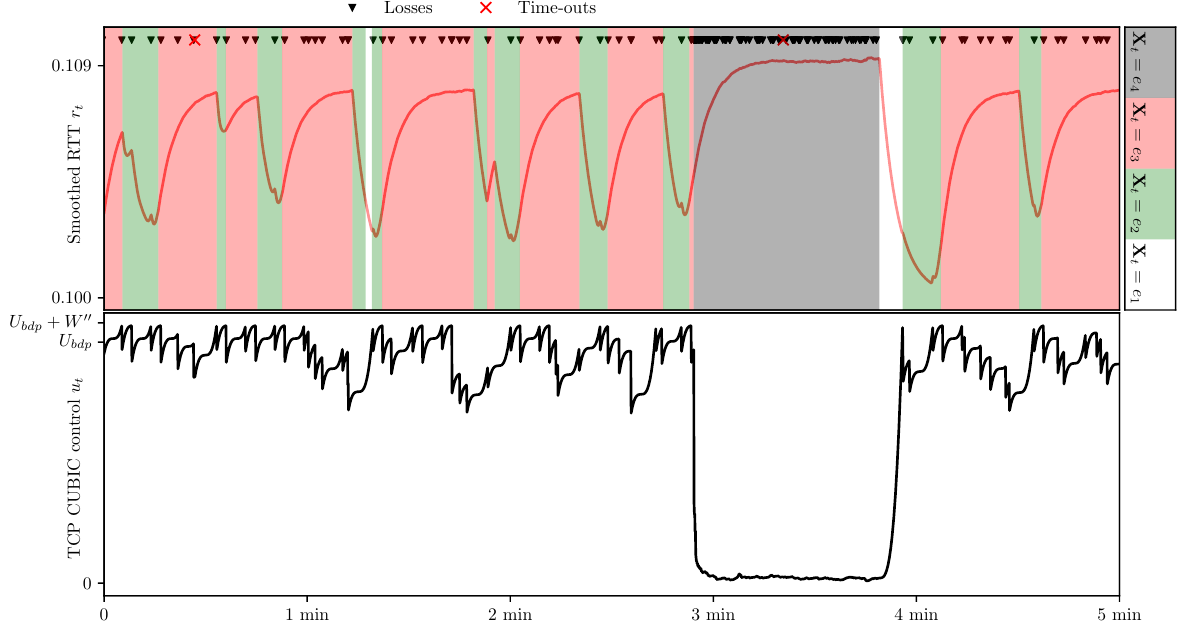
Figure 3. TCP channel simulation example for CUBIC control